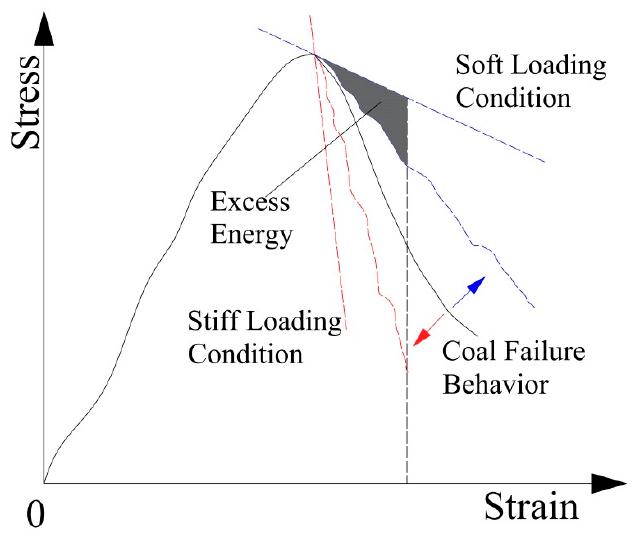
Figure 3. Effect of stiffness of the loading system on the behavior of coal failure.